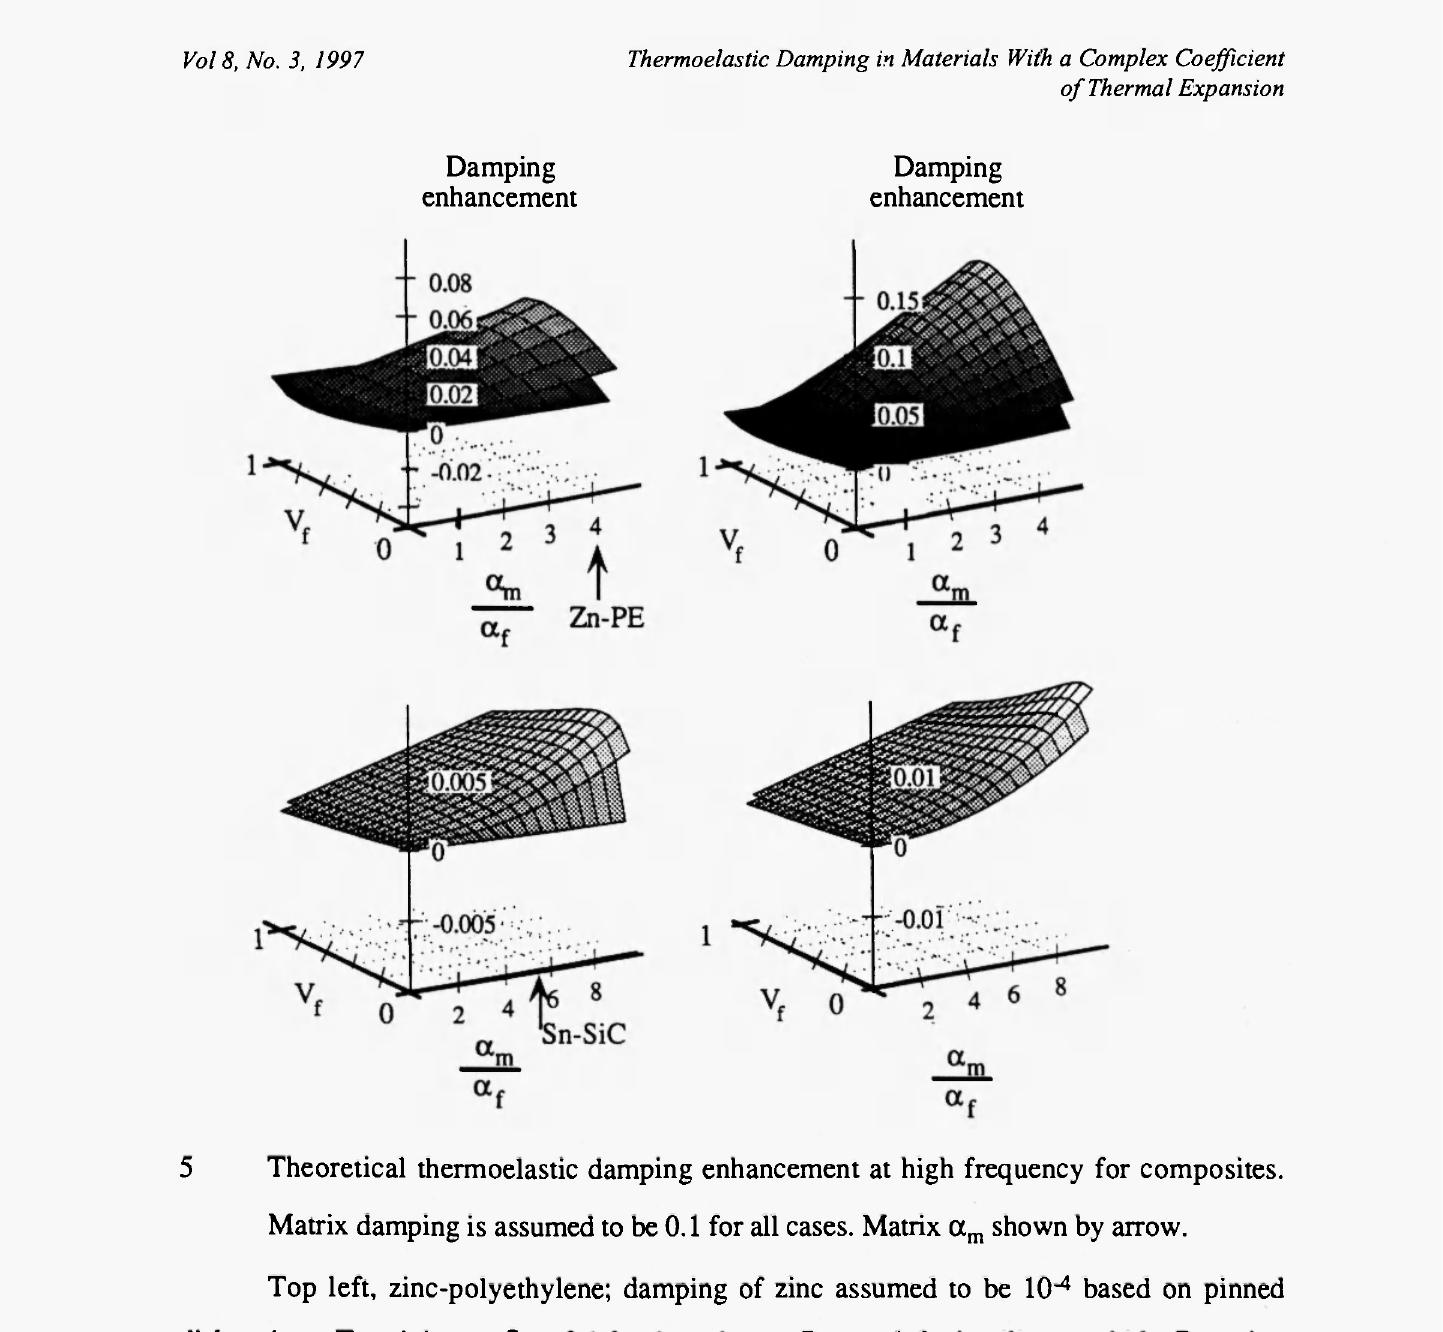
Theoretical thermoelastic damping enhancement at high frequency for composites. Matrix damping is assumed to be 0.1 for all cases. Matrix a shown by arrow. m Top left, zinc-polyethylene; damping of zinc assumed to be 1(H based on pinned dislocations. Top right: tan δ = 0.1 for the polymer. Bottom left, tin-silicon carbide. Damping α of silicon carbide assumed to be zero. Bottom right, tan δ = 0.1 for the α